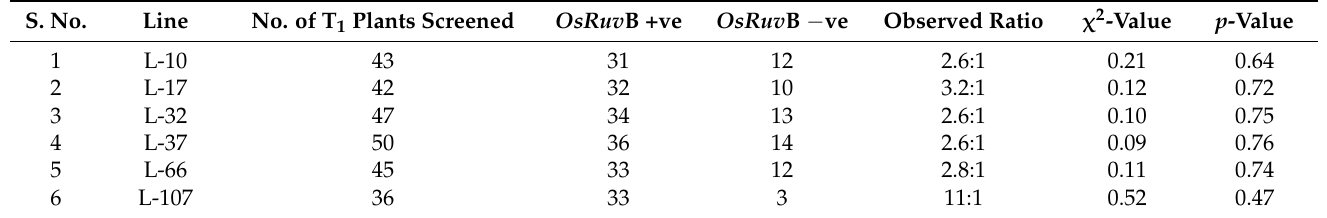
Table 4. Segregation analyses of the transgene in T 1 progeny of transgenic pigeon pea based on PCR analysis.